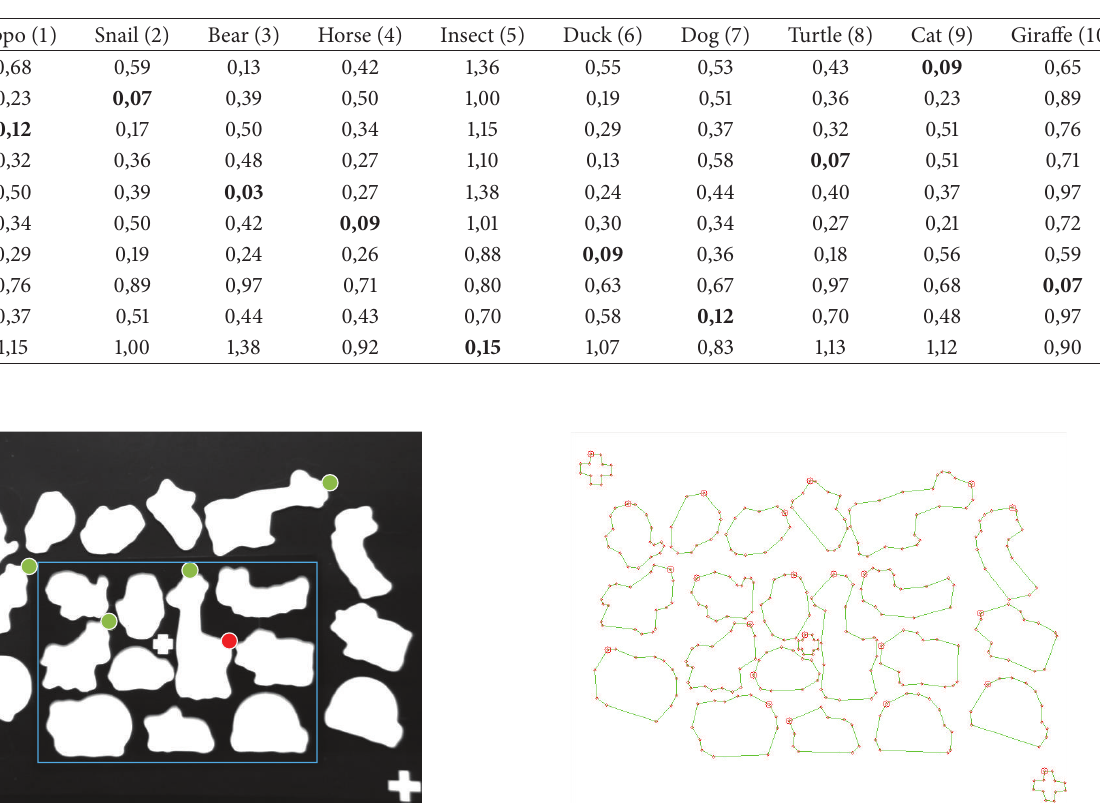
Table 1: The Euclidean distance matrix of MWD calculated from the approximation signal.